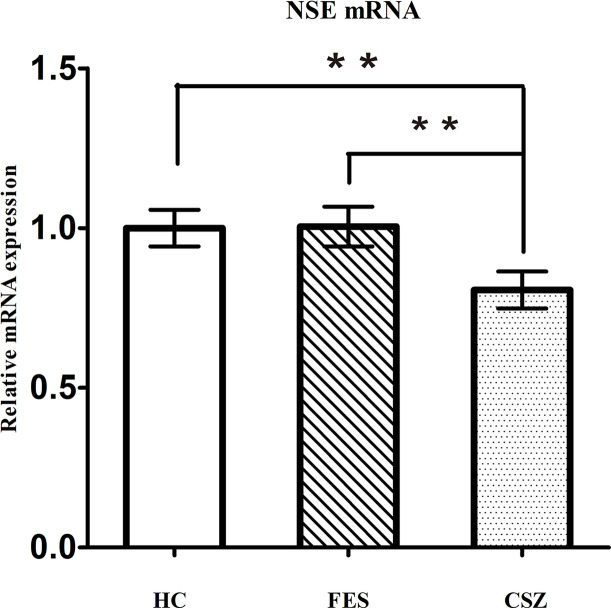
Representative of the relative mRNA expression of NSE gene. ** means P < 0.01. Error bars denote mean and SD. FES, first-episode schizophrenia; CSZ, chronic schizophrenia; HC, healthy controls; NSE, neuron-specific enolase.